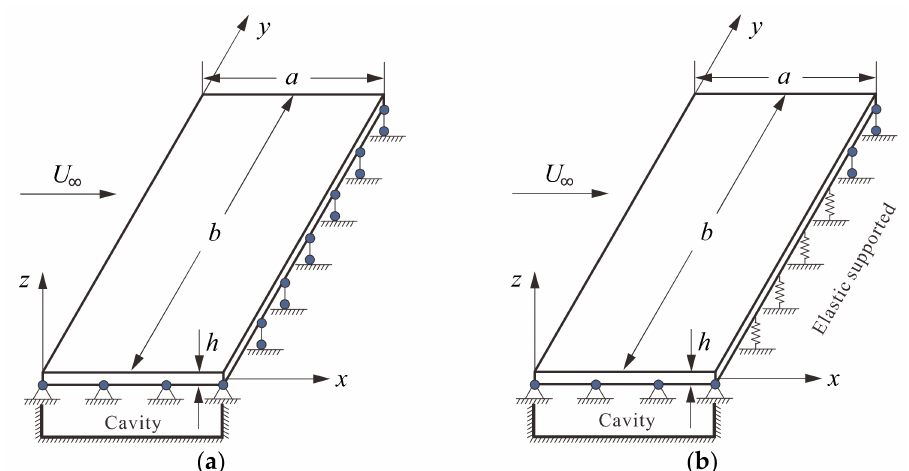
Figure 1. ( a ) A panel with simply supported boundaries on four sides; ( b ) a panel with elastically supported